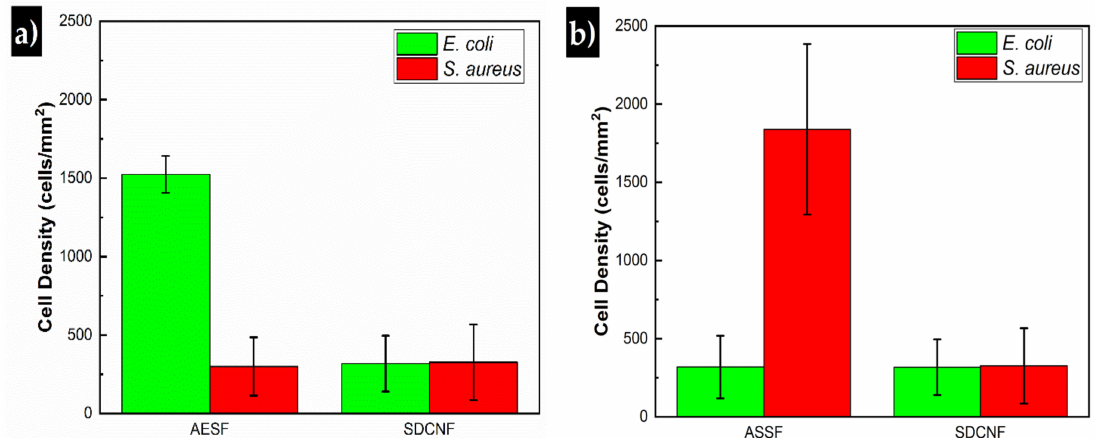
Figure 11. Capture cell density of functionalized fibers and neat silver doped carbon nanofibers using both E. coli and S. aureus. a ) Capture cell density of AESF fibers mats vs SDCNF fiber mats after microfluidic studies b ) Capture cell density of ASSF fibers mats vs SDCNF fiber mats after microfluidic studies.